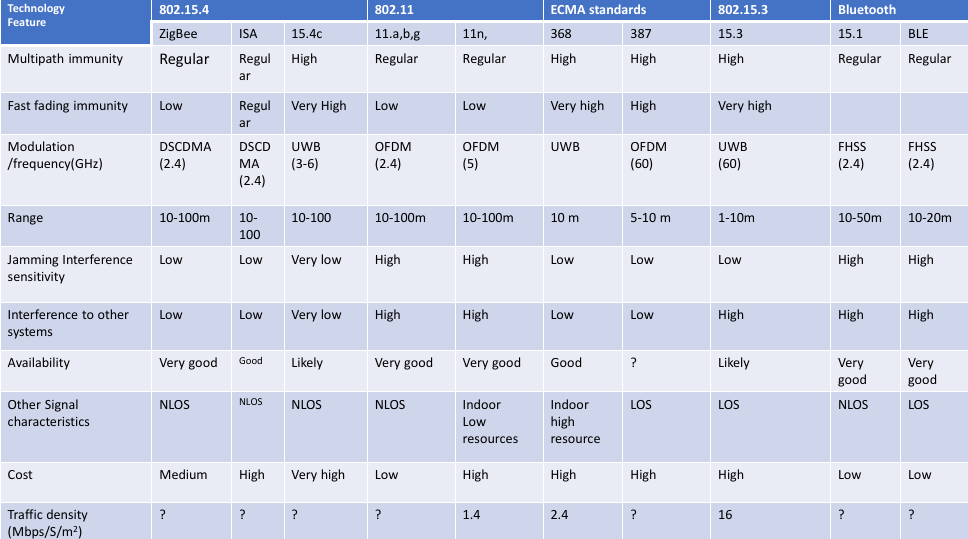
Figure 6. COTS PHY-Layer